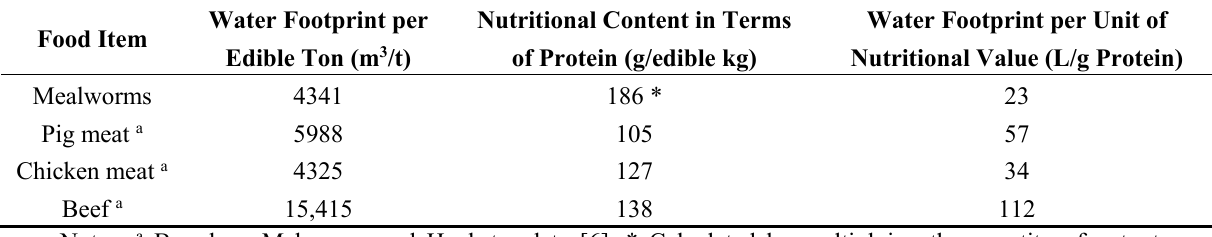
Table 6. The water footprint of food products from animal origin in terms of protein